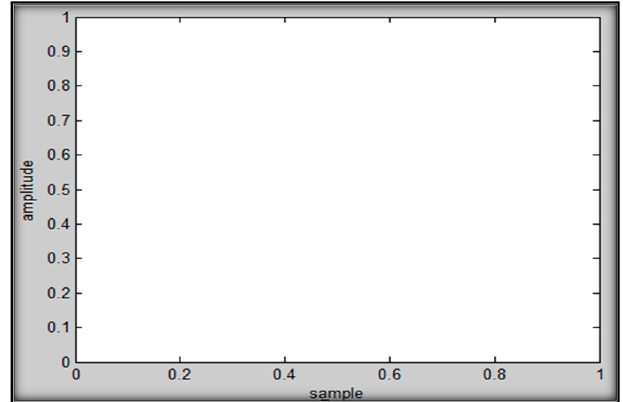
Figure 13. No data transmitted from Tx.